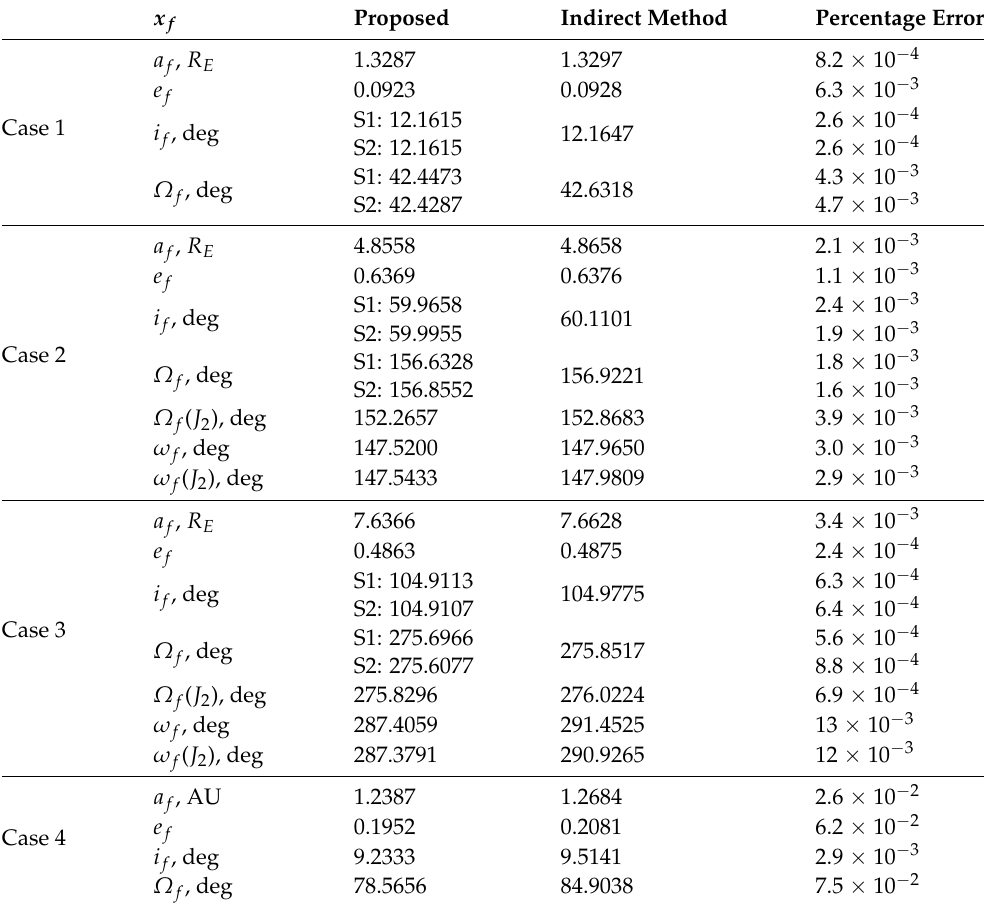
Table 4. Variation maxima of the orbital elements over a fixed flight time.